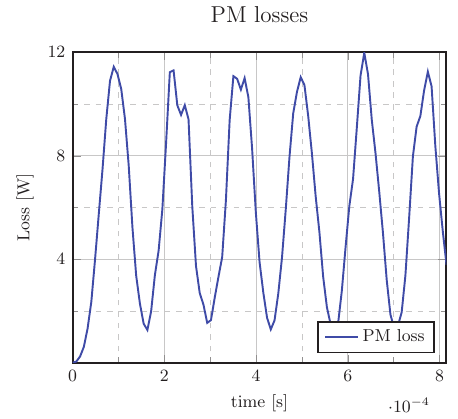
Figure 13. PM losses in the PM ring at 2300